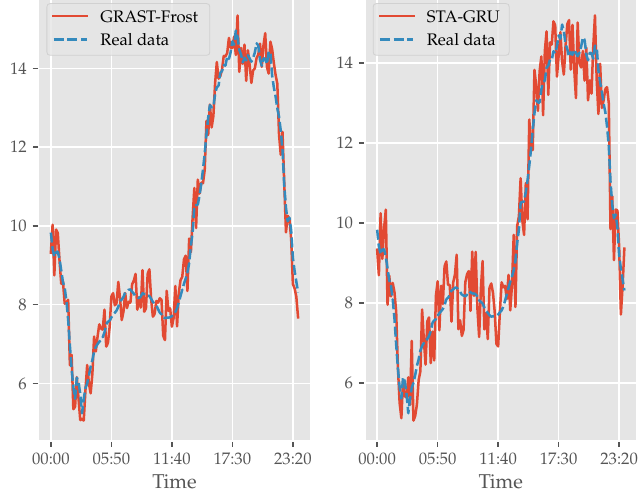
Figure 8. On left, there is a comparison of GRAST-Frost model with real data; on right, a comparison of STA-GRU model with real data.